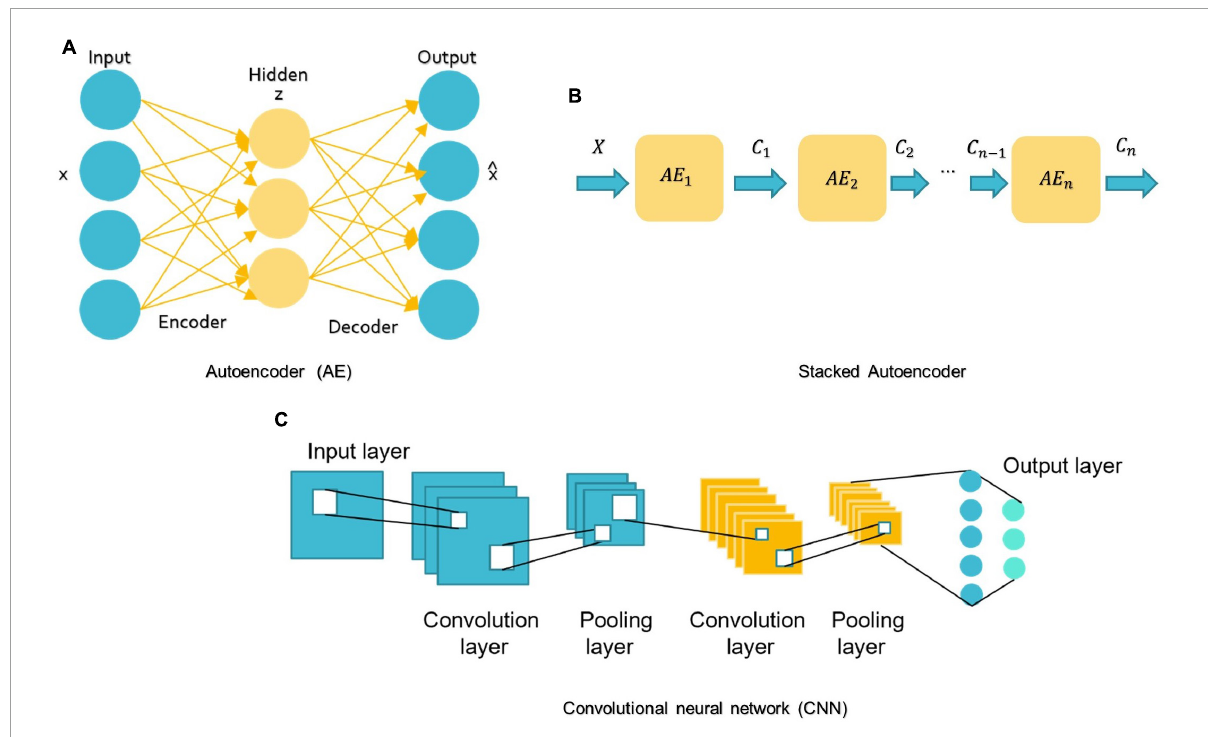
FIGURE7 Schemes of DL algorithms are commonly used in MRI-based studies to diagnose ASD. (A) AE: autoencoder; (B) Stacked Autoencoder; (C) CNN: convolutional neural